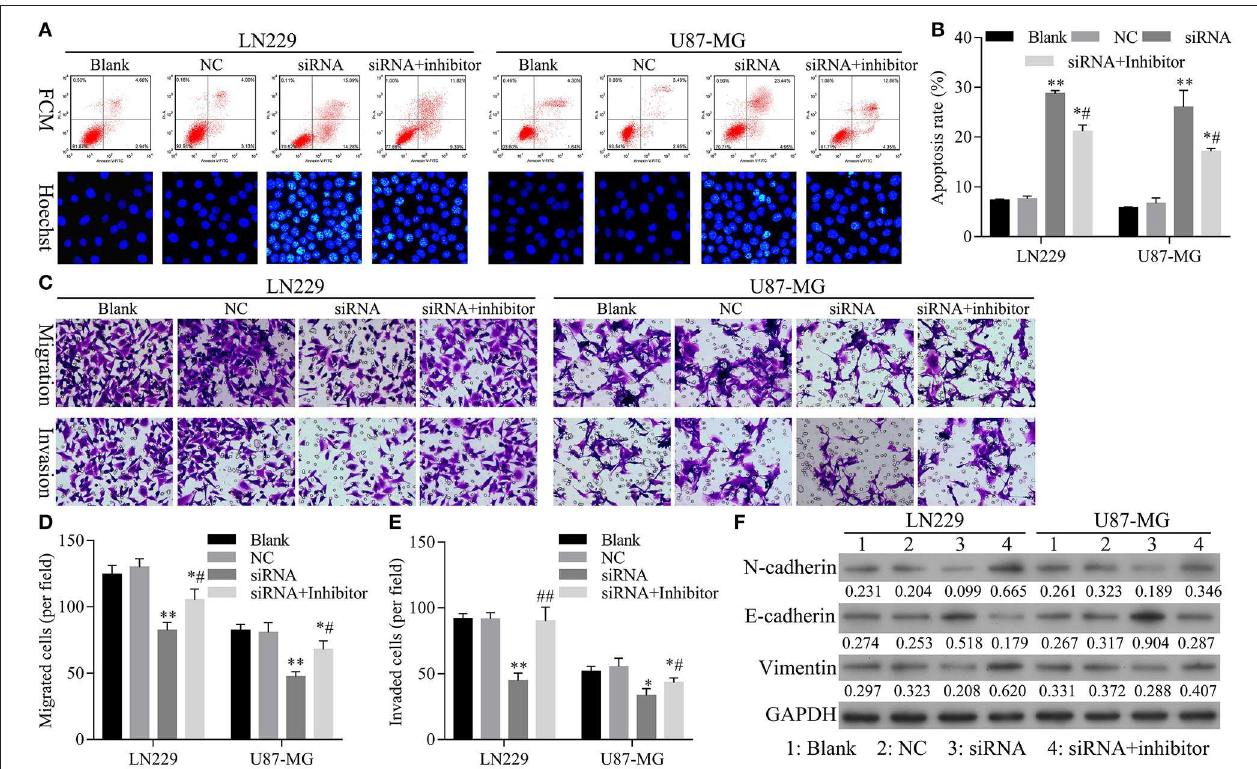
FIGURE 6 | The restoration of miR-661 inhibition led to inhibition of apoptosis, and promoted glioma cell migration, invasion, and EMT mediated by hsa_circ_0088732 knockdown. LN229 and U87-MG cells were transfected with hsa_circ_0088732 siRNAs and/or an miR-661 inhibitor, respectively. (A,B) Cell apoptosis was detected by PI/Annexin V FITC and Hoechst 33258 staining (* P < 0.05, ** P < 0.01 vs. NC group; # P < 0.05 vs. siRNA group). (C–E) Cell migration and invasion capabilities were evaluated by Transwell assays. (F) The levels of E-cadherin, N-cadherin, and vimentin expression were determined by western blotting. NC: negative control, siRNA: hsa_circ_0088732 siRNAs, Inhibitor: miR-661